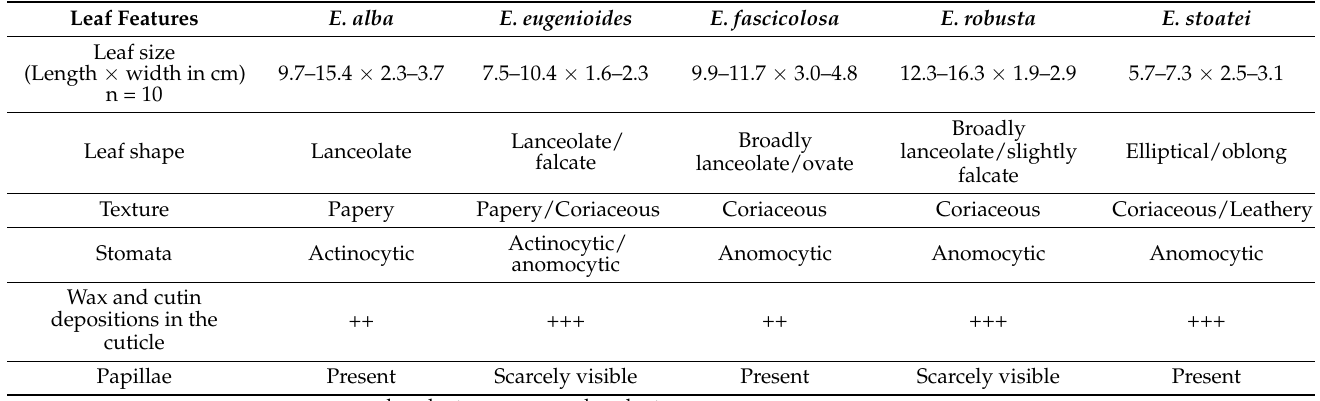
Table 1. Main macromorphological and micromorphological characteristics of the leaves of the Eucalyptus species